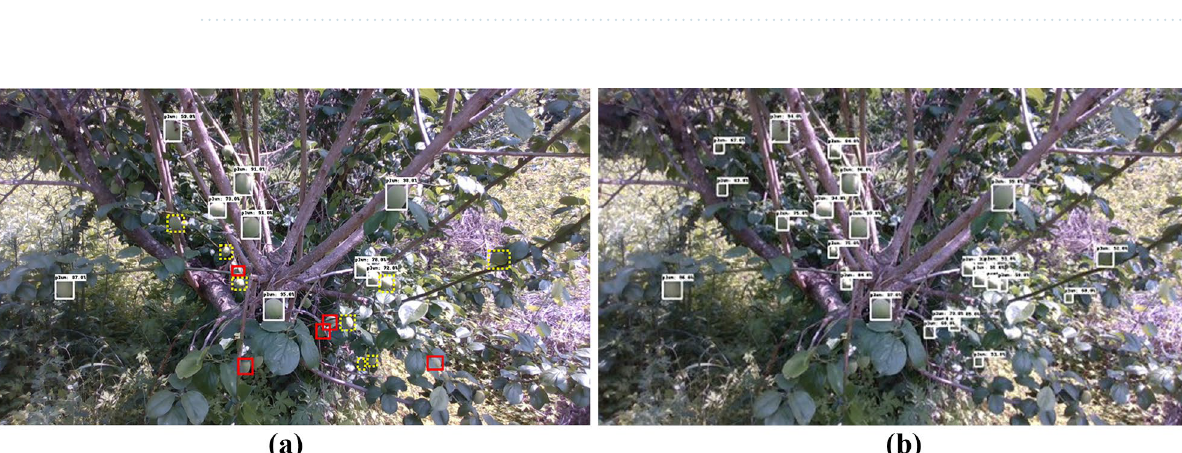
Table 2. Average precision results of image cropping models.